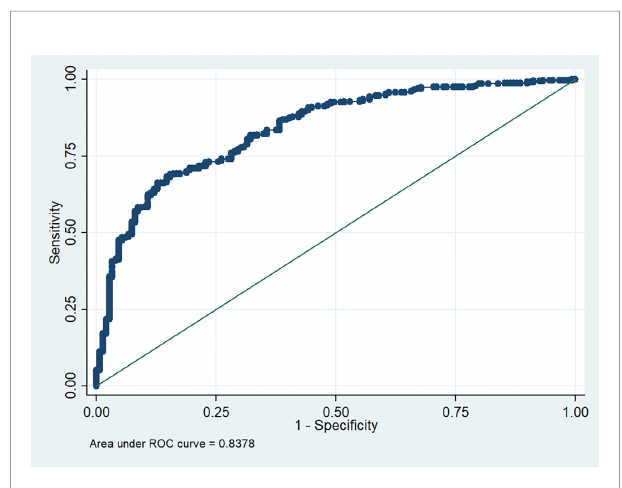
FIGURE 1 | ROC curve for the association model of rs2285666 ACE2 polymorphism with oxygen